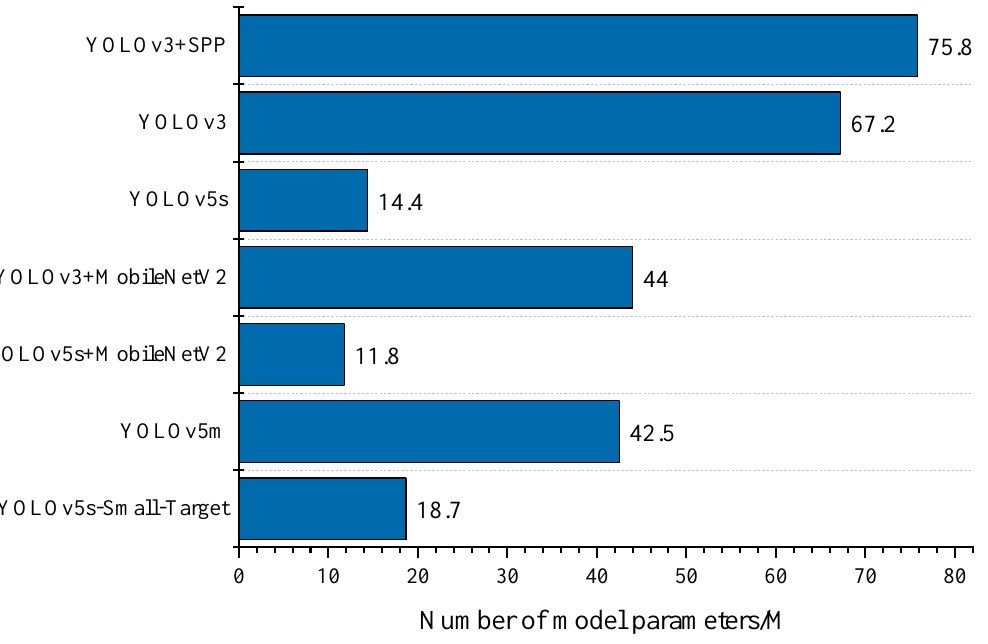
Figure 22. Comparison of the number of parameters of different models.